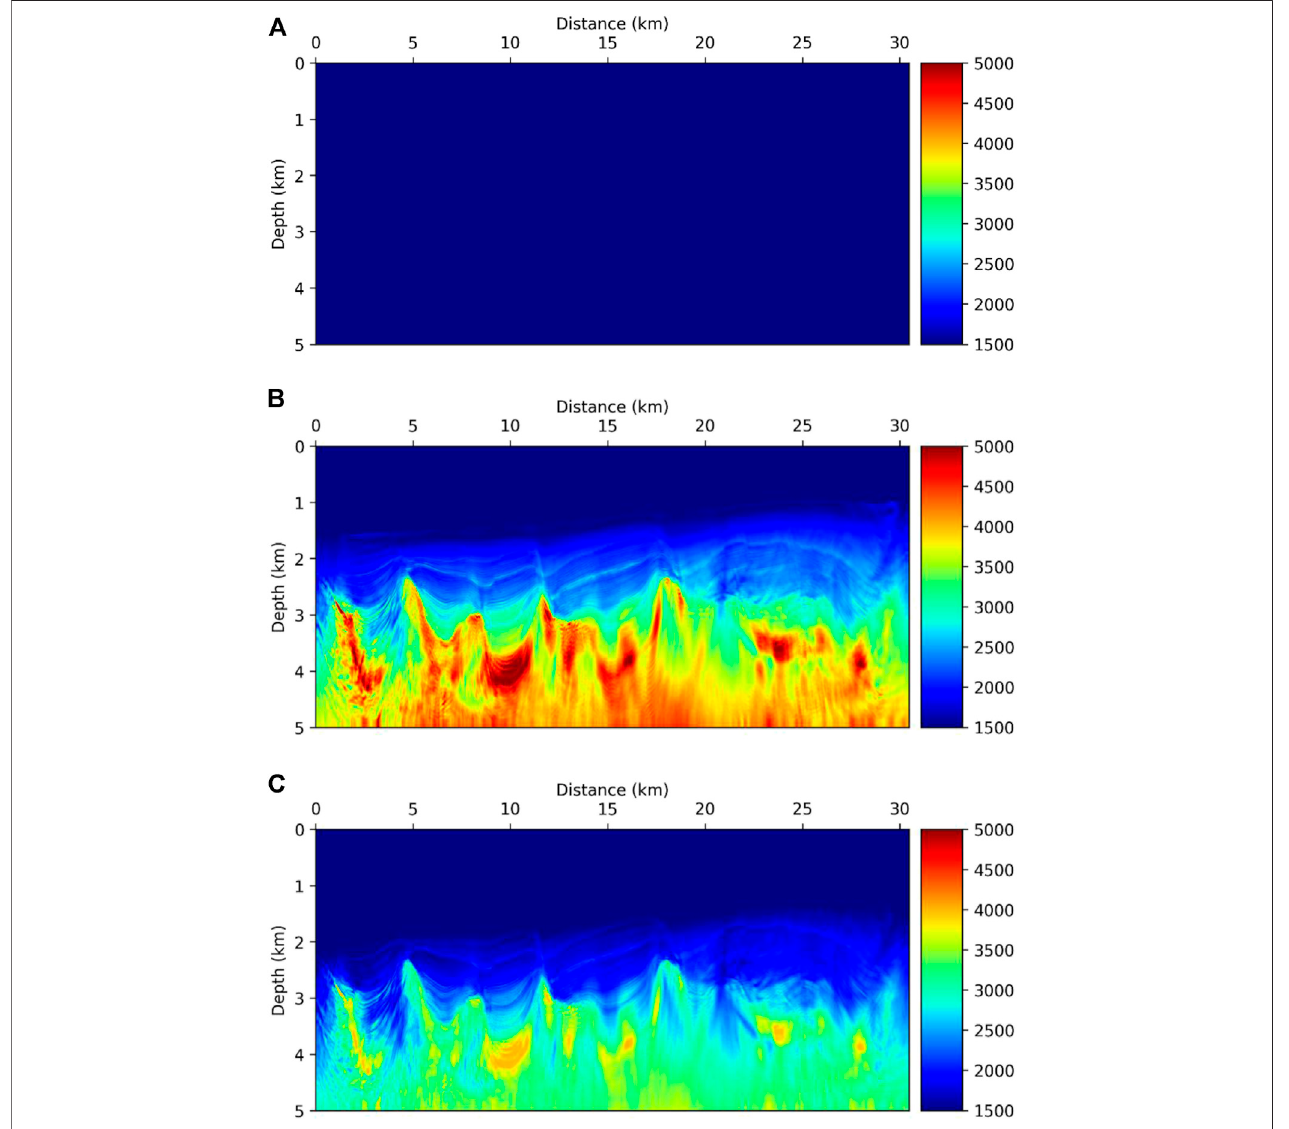
FIGURE 10 | (A) Homogeneous velocity model, (B) smoothed velocity inverted model by FWI, and (C) smoothed and 20% reduced velocity except sea water velocity model from (B) .